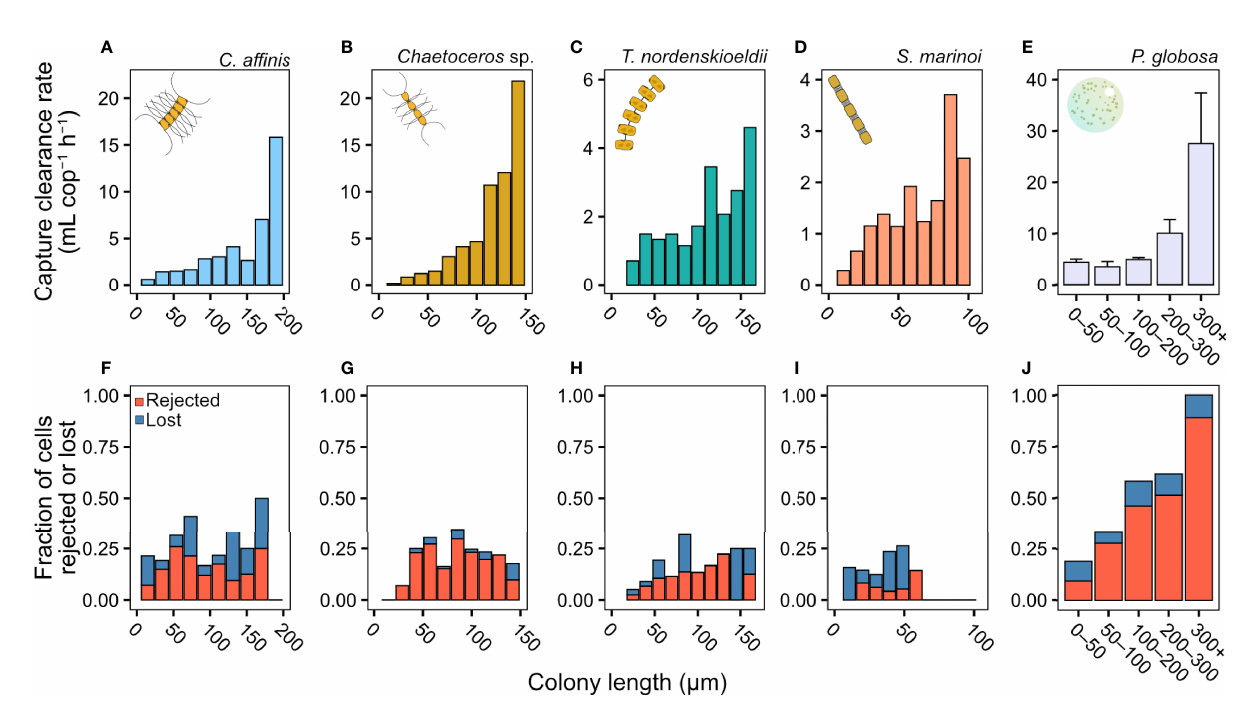
FIGURE 2 | Copepodite feeding rate (from video observations). (A – E) Capture clearance rate (mL copepod − 1 h − 1 ), and (F – J) the fraction of different capture outcomes (lostor rejected cells). If prey was not rejected or lost means it was ingested. Clearance rates on diatoms are pooled results from the 3 – 5 copepods used. Clearance rates for P. globosa (E) are means ± SD from the two experiments and outcomes (J) were pooled for each size range from both experiments. The fraction of colonies rejected or lost during handling was independent of colony size in the diatoms (mixed effects logistic regression, z = 1.47, p = 0.14). In P. globosa the fraction of colonies rejected or lost increased with colony size (logistic regression, z = 6.50, p = <0.001). Length refers to chain length in the diatoms and diameter in P. globosa . Please not differences in axis